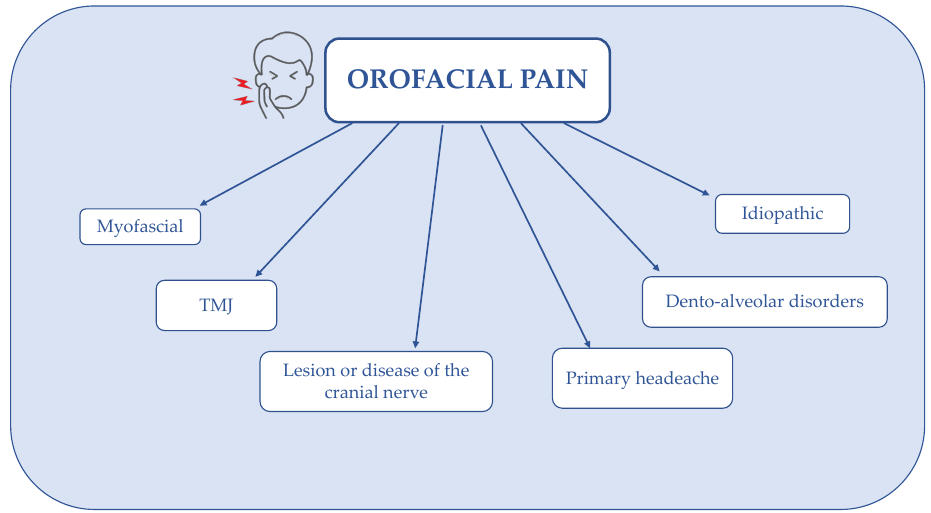
Figure 4. The etiology of pain in the oral mucosa according to the International Classification of Orofacial Pain (ICOP). Abbreviations: TMJ, temporomandibular